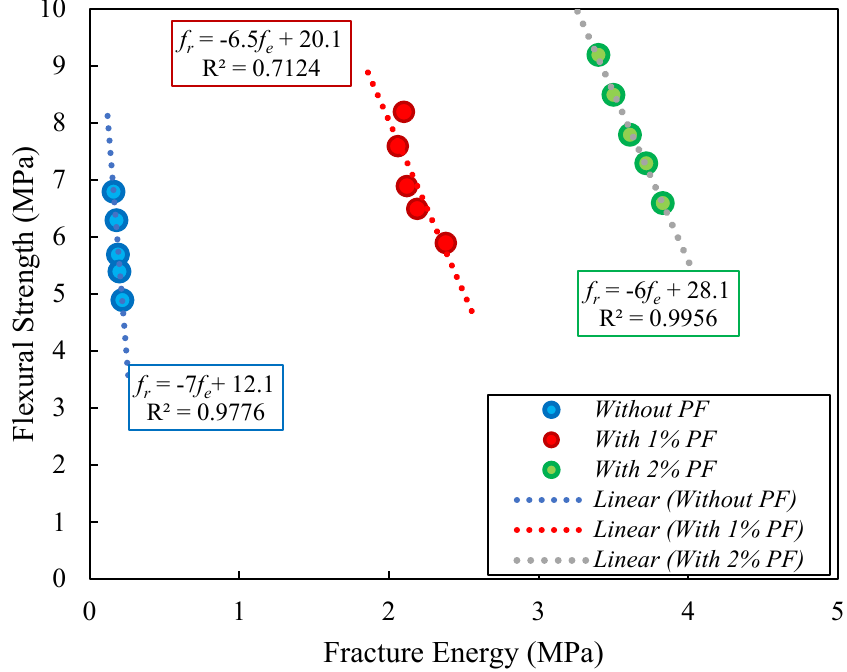
Figure 14. Relation among flexural resistance and fracture energy of sample containing different PF and RTA fractions